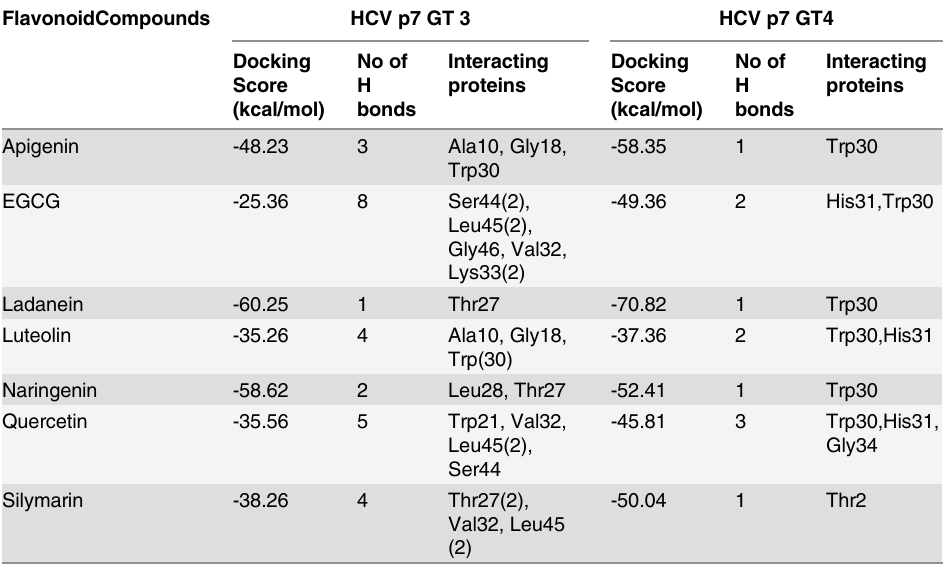
Table 8. Selected bioactive flavonoids and their docking score along with the number of HBond for- mation with modeled p7 ion channel from both genotypes as obtained from molecular docking using CLC drug discovery